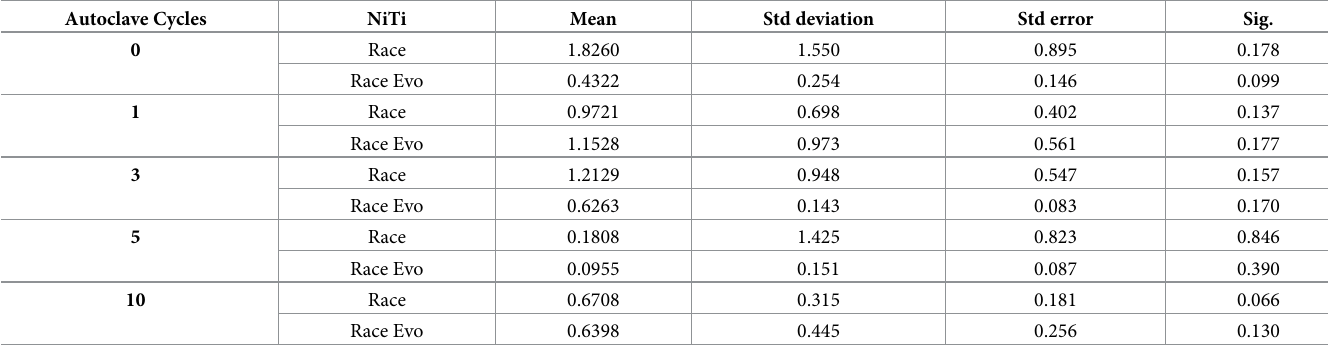
Statistical significance was set at p �